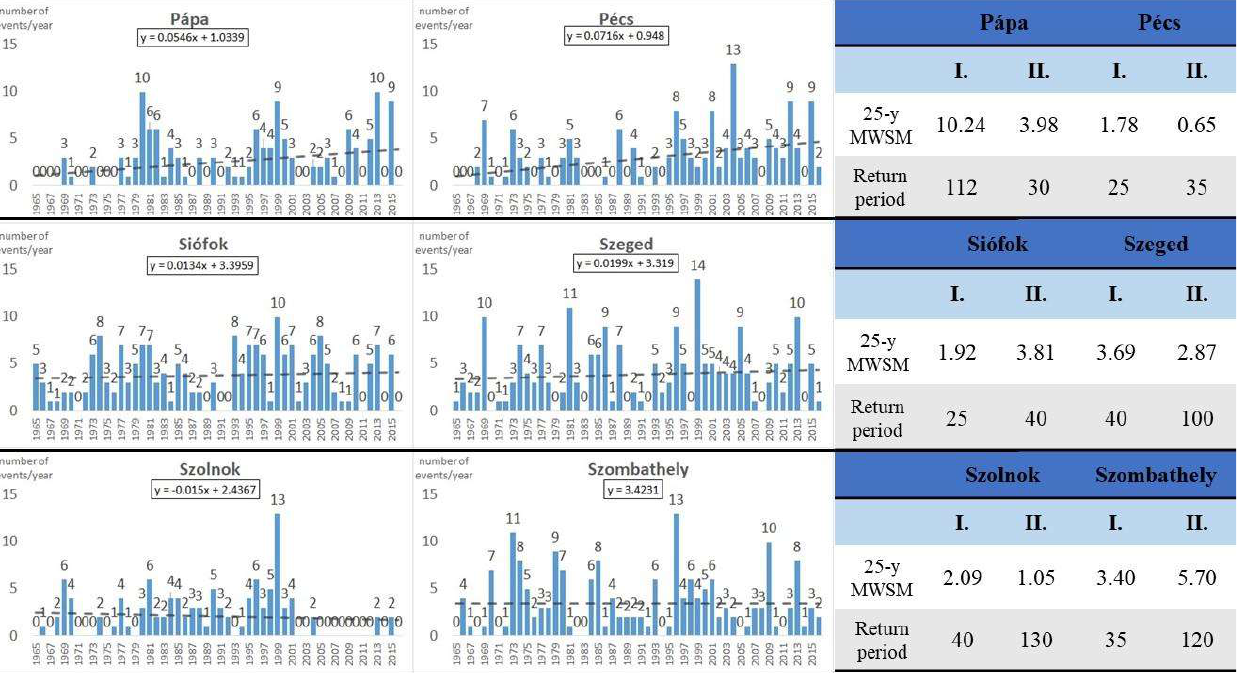
Figure 8. Annual Number of Cases (ANC) of wet snow events between 1965–2016 with a linear trend line (dotted line) and its equation ( left ) and the 25-year Maximum Wet Snow Mass (MWSM) (kg·m −1 ) and its Return period in the 1965–1990 period (Column I.) and in the 1991–2016 period (Column II.) ( right ) in Pápa, Pécs, Siófok, Szeged, Szolnok, Szombathely. Table 5. The Number of Cases (NC) between 1965–2016, the trend analysis of the Annual Number of Cases (ANC) based on Figures 7 and 8 and of the calculated Maximum Wet Snow Mass (MWSM) in kg · m − 1 with t -test ( p = 0.05) between 1965–2016. The critical t -value is 2.0086. Significant changes of the parameters are shaded with red (increase) or blue